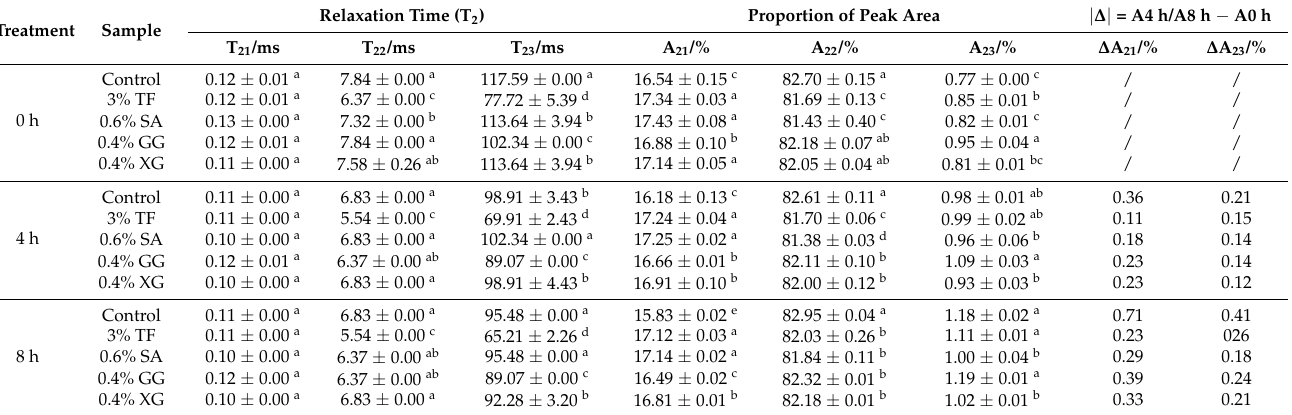
Table 2. The changes of relaxation time T 2 and peak area ratio of TF, SA, GG and XG noodles under different storage